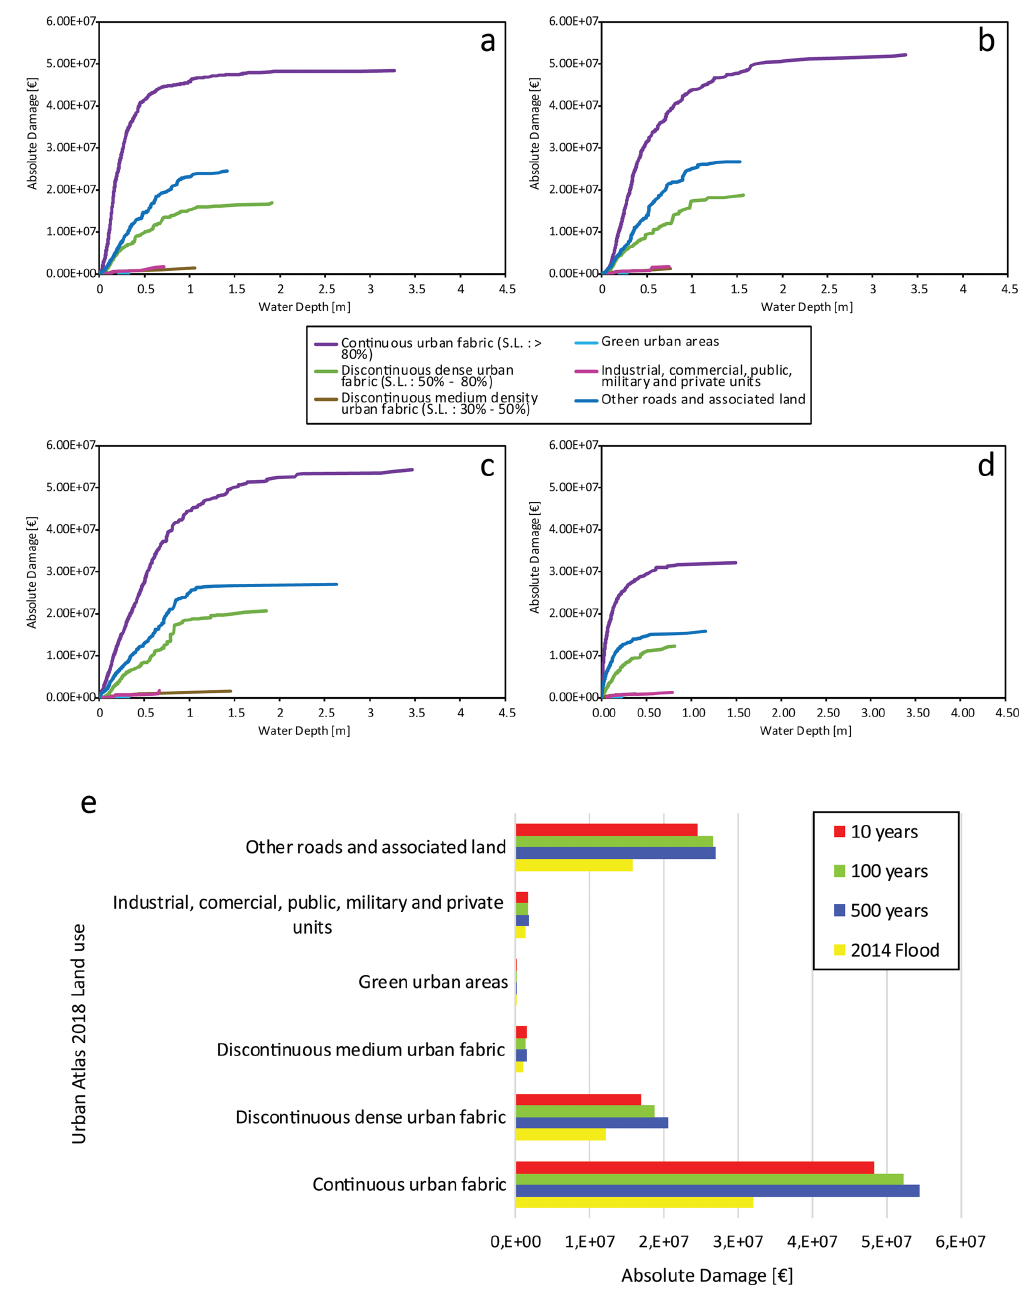
Figure 10. Site-specific mesoscale depth–damage curves for the residential sector. The x axis represents the inundation depth, and the y axis represents the damage fraction corresponding to the inundation depth for a specific land-use class assuming return periods of (a) 10, (b) 100 (c) 500 years and (d) 2014 flood. (e) Comparison of total absolute damage distribution at